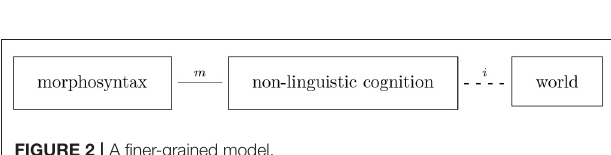
FIGURE 1 | The traditional model in truth-conditional semantics.